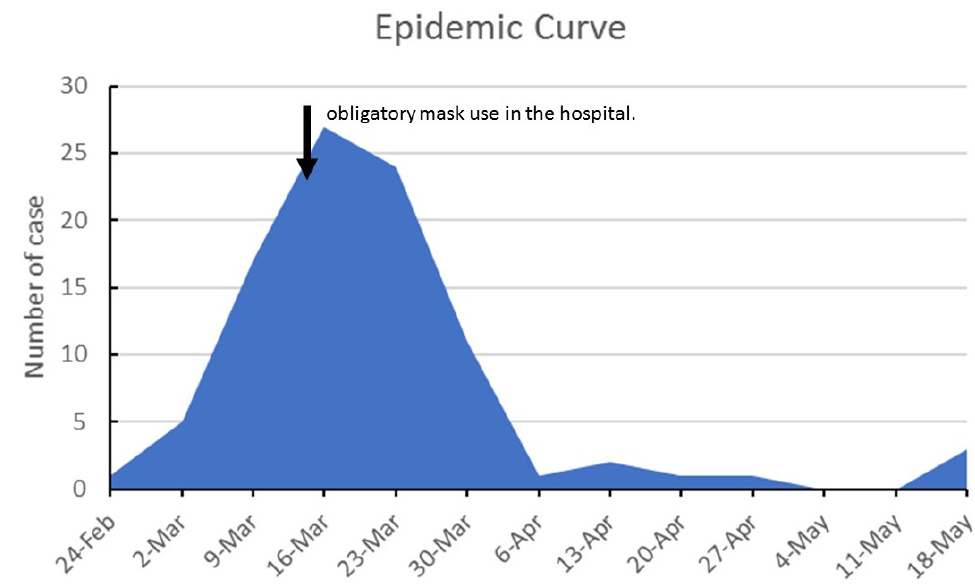
Figure 1. Epidemic Curve of cases in Health Care workers February–May 2020.